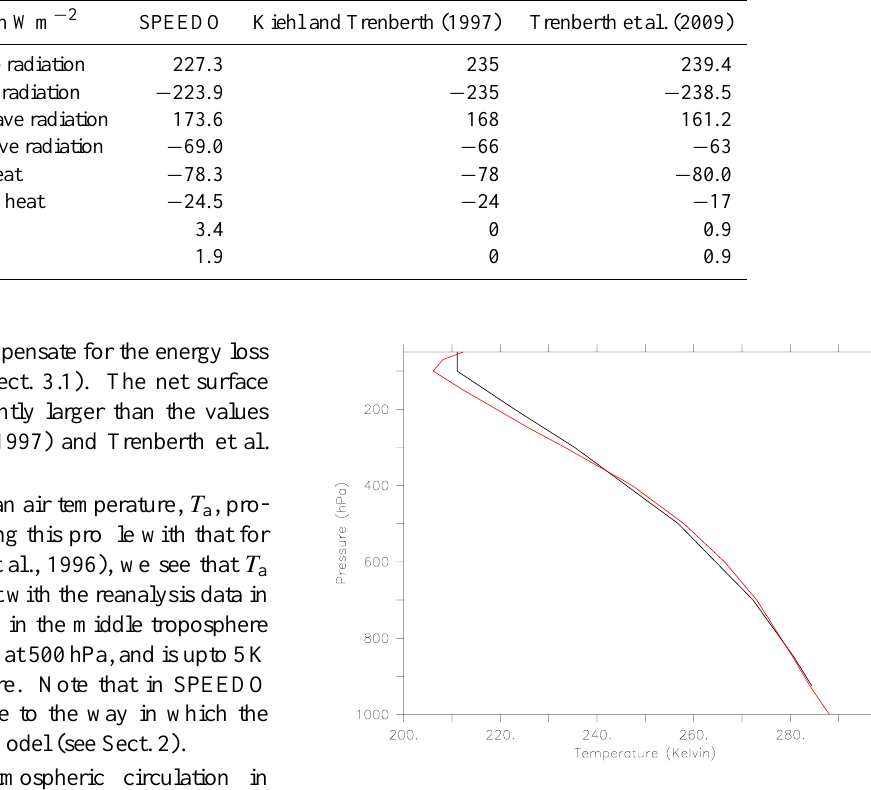
Fig. 3. The global annual mean air temperature profile in K from SPEEDO (black) and from the reanalysis data from Kalnay et al. (1996)